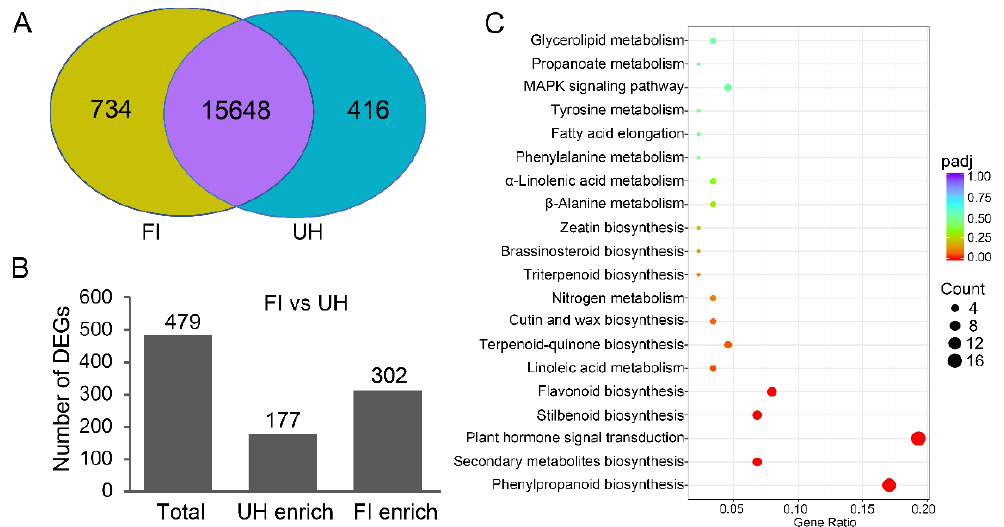
Figure 2. Transcriptome analysis identifies differentially expressed genes (DEGs) between upper hypocotyl (UH) and the first stem internode (FI) of the stem of accession line 337. ( A ) Venn diagram of detected genes in transcriptome of UH and FI. The regions filled with purple, yellow, and blue indicate genes detected in both organs, only in FI, and only in UH, respectively. ( B ) Differentially expressed genes between FI and UH. ( C ) Enrichment of Kyoto Encyclopedia of Genes and Genomes (KEGG) biochemical pathways in the FI.